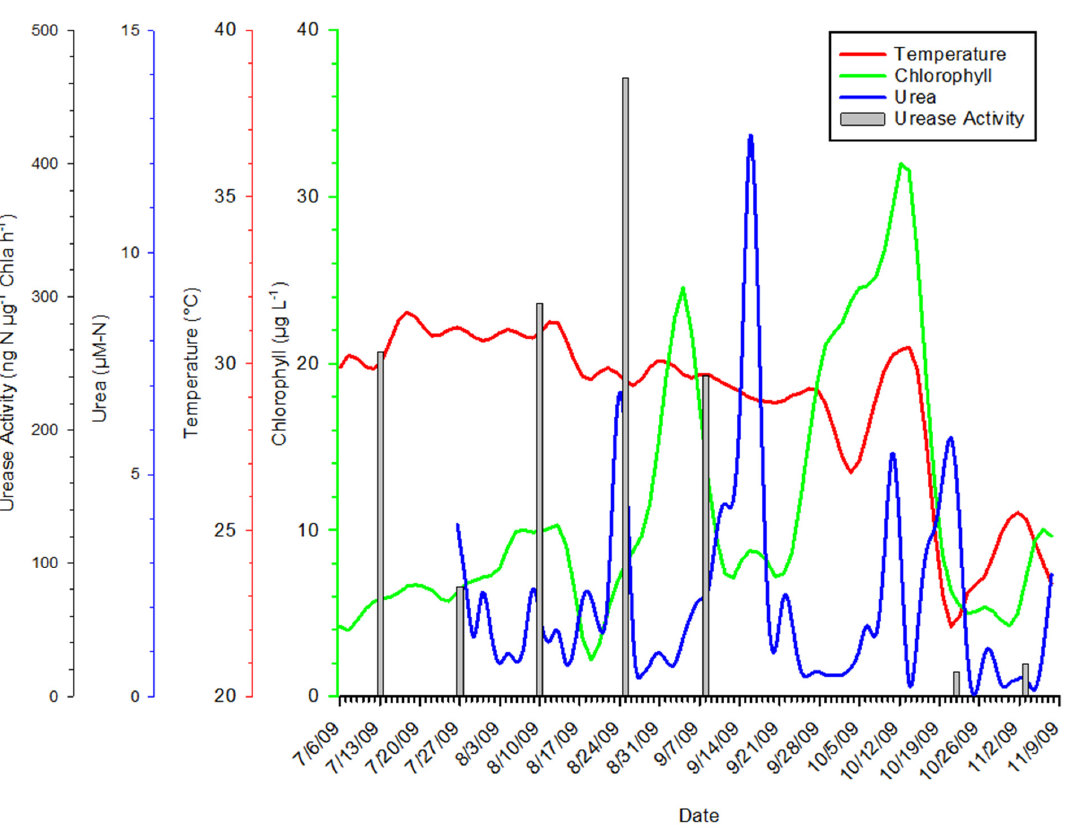
Figure 7. MARVIN sensor data showing the relationship of temperature, chlorophyll a and urea concentrations. Urease measurements were made on discrete water samples collected biweekly.